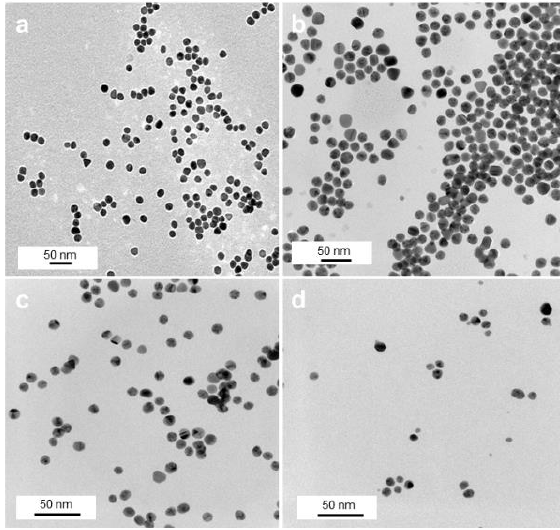
Figure 2. TEM images of AuCit ( a ), AuThioPEG ( b ), AuPVP ( c ), and AuPVA ( d ) NPs, captured at 50,000× ( a ), 100,000× ( b ), and 150,000× ( c , d ) magnification.